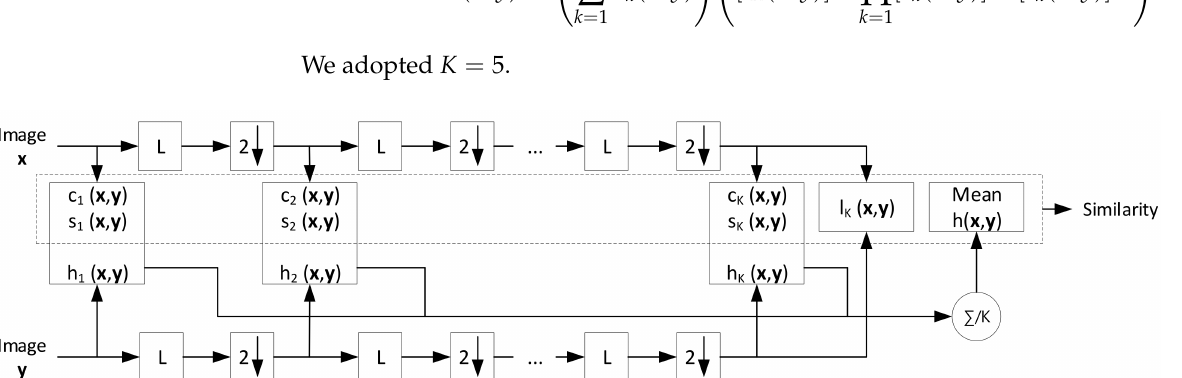
Figure 5. MS-ISSIM-S measurement procedure diagram. L denotes low-pass filtering and 2 ↓ refers to down-sampling by a factor of